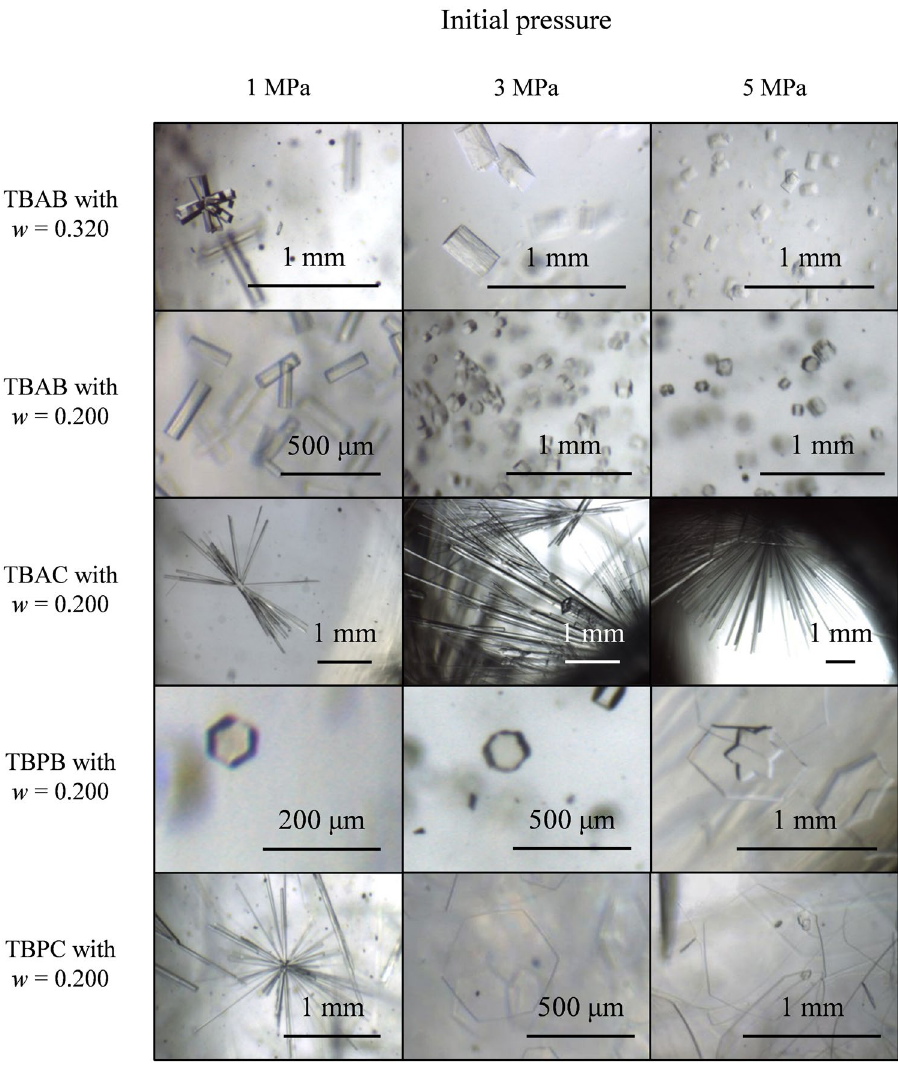
Figure 1. Single crystals of ionic clathrate hydrates formed in gas separation